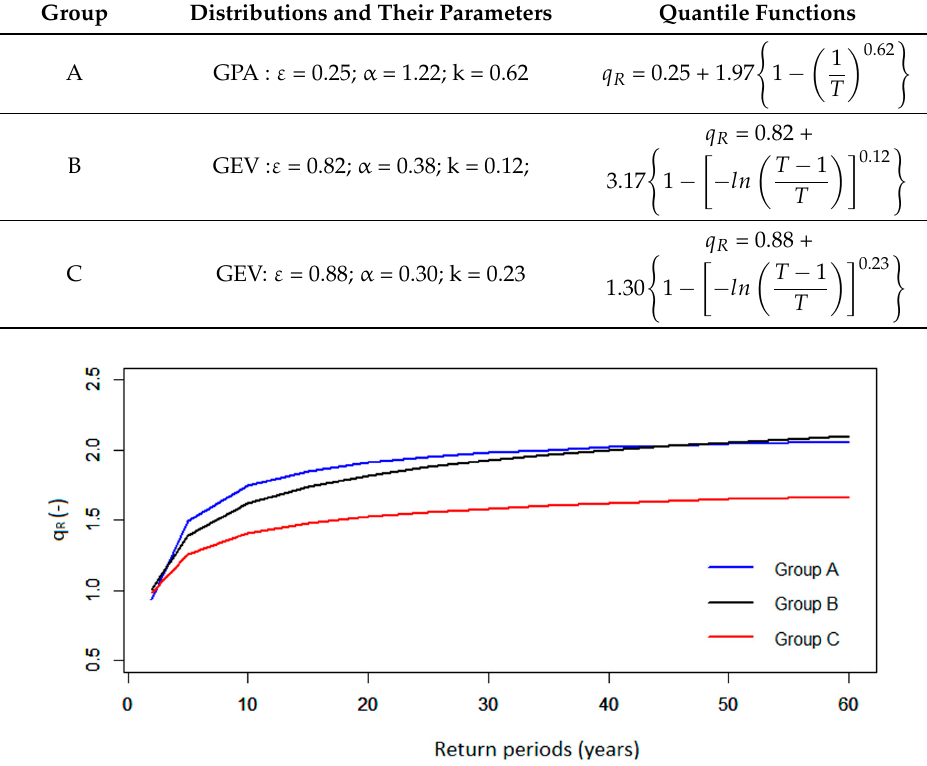
Figure 7. Regional growth curves of the homogeneous groups. q R “ Q p T q{ Q m ; with Q m , the index flood, and Q p T q , the flood quantile of return period T.